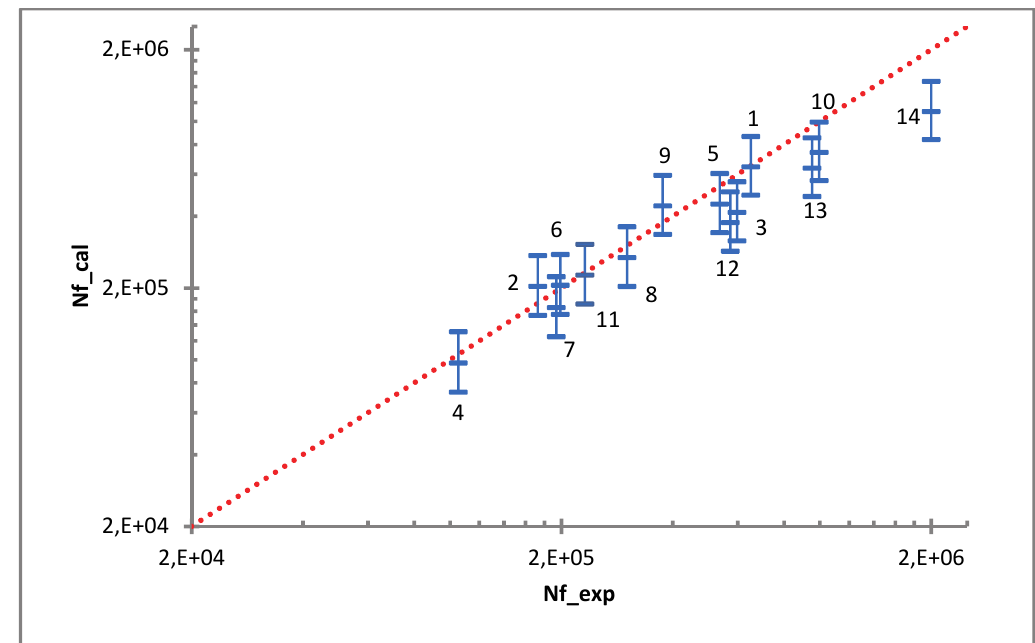
Figure 2: Comparison of experimentally acquired and calculated life